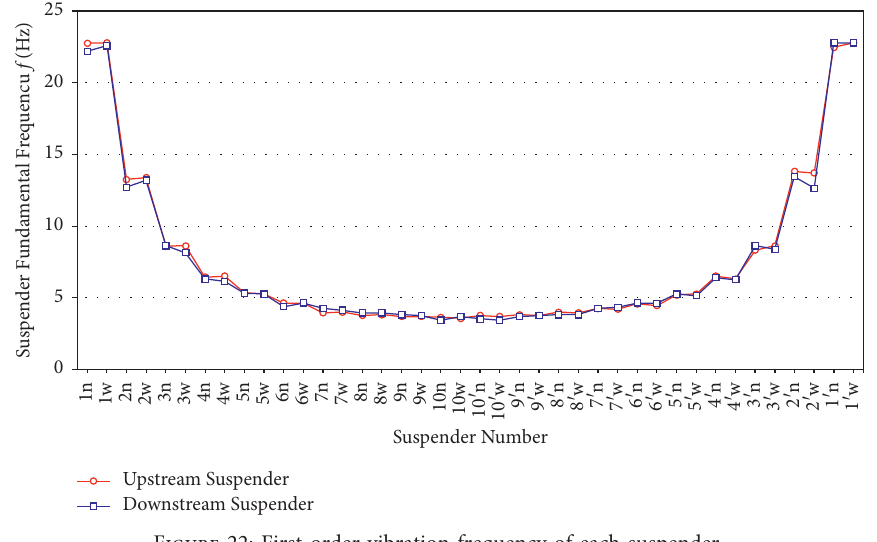
Figure 22: First-order vibration frequency of each